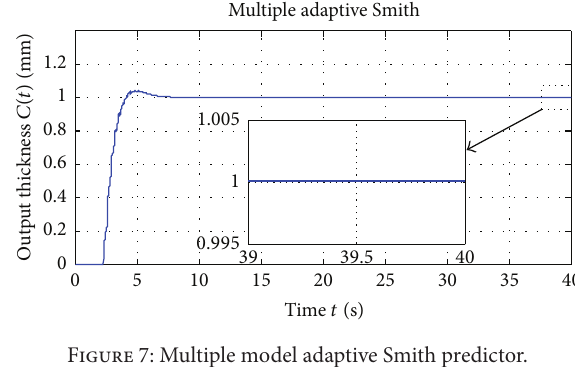
Figure 7: Multiple model adaptive Smith predictor.